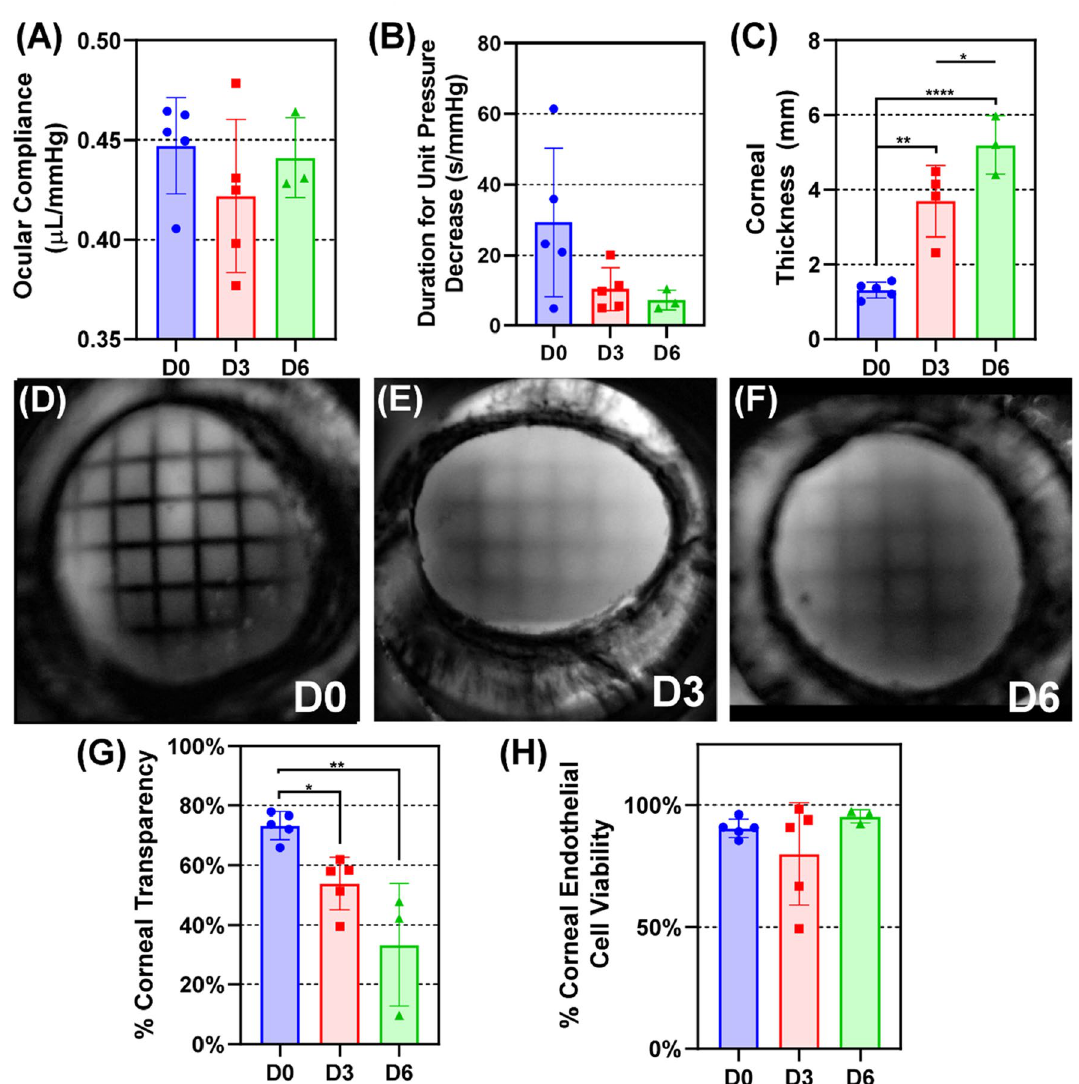
Figure 3. Assessment of corneal properties for AS tissue maintained in OC. ( A ) Ocular compliance for control D0, D3, D6 data. ( B ) Calculated durations per unit IOP from 18 to 15 mmHg for D0, D3, and D6 uninjured, control tissue. ( C ) Quantification of corneal thickness for uninjured tissue. ( D-F ) Representative processed images for ( D ) D0, ( E ) D3, and ( F ) D6 control eyes for assessing transparency. ( G ) Quantification of corneal transparency. ( H ) Quantification of tissue viability. Results are shown as mean and error bars denote standard deviation throughout. Asterisks denote (*) p < 0.05, (**) p < 0.01, (***) p < 0.001, and (****) p < 0.0001 as determined by one-way ANOVA, post-hoc Tukey’s